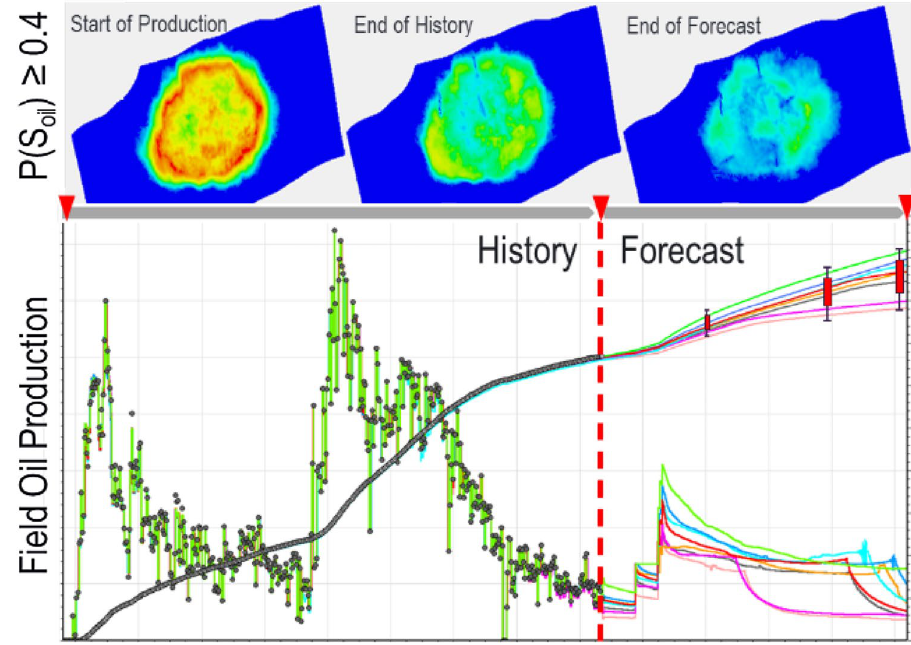
Fig. 13 Maps on the top show the probability distribution for saturation oil P ( S oil ) ≥ 0.4 at the start of production (left), end of history (mid), and at the end of the forecast period (right). Profiles below show field oil production rate and total for all history matched solution cases